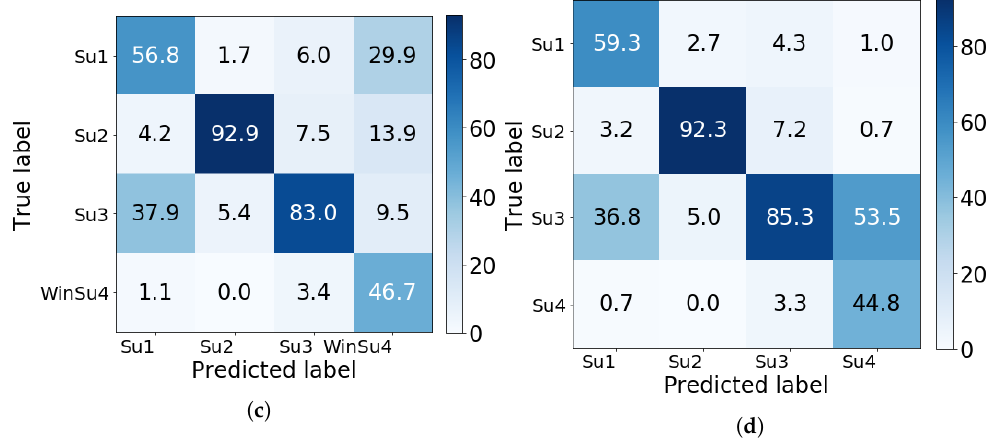
Figure 7. Confusion Matrices of ACDG generated data and ground truth data in the Summer ↔ Winter. ( a ), C Win applied on the ACDG generated SuWin4 fault transferred from summer and three other ground truth data sets collected in winter. ( b ), C Win applied on ground truth data sets collected in winter. ( c ), C Su applied on the ACDG generated WinSu4 fault transferred from winter and three other ground truth data sets collected in summer. ( d ), C Su applied on ground truth data sets collected in